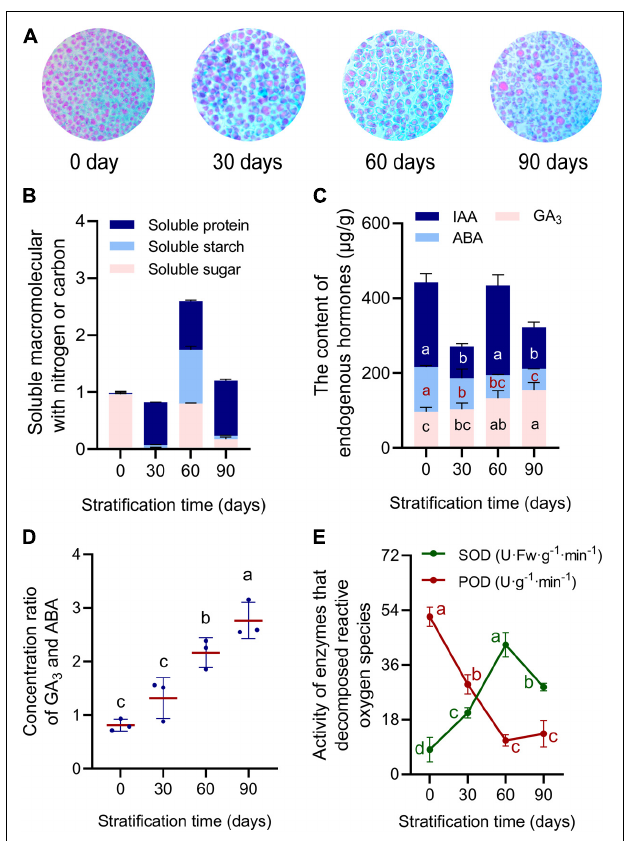
FIGURE 2 | Physiological indicators in Rosa rugosa embryos were measured during stratification for 0, 30, 60, and 90 days at 4 ◦ C. (A) Size of starch granules increased and number decreased during stratification. (B) Soluble macromolecules (min–max normalized) with nitrogen or carbon peaked at 60 days of treatment. (C) Contents of Gibberellin (GA 3 ) GA 3 and Abscisic acid (ABA) changed linearly, whereas that of Auxin (IAA) changed in a waveform. (D) GA 3 /ABA ratio continued to increase. (E) Superoxide dismutase (SOD) and peroxidase (POD) activities showed opposite trends.